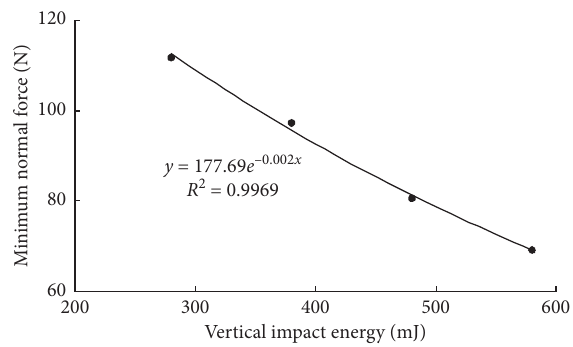
Figure 8: Time history curve of the normal force on the contact surface with the vertical impact energy of 380mJ.